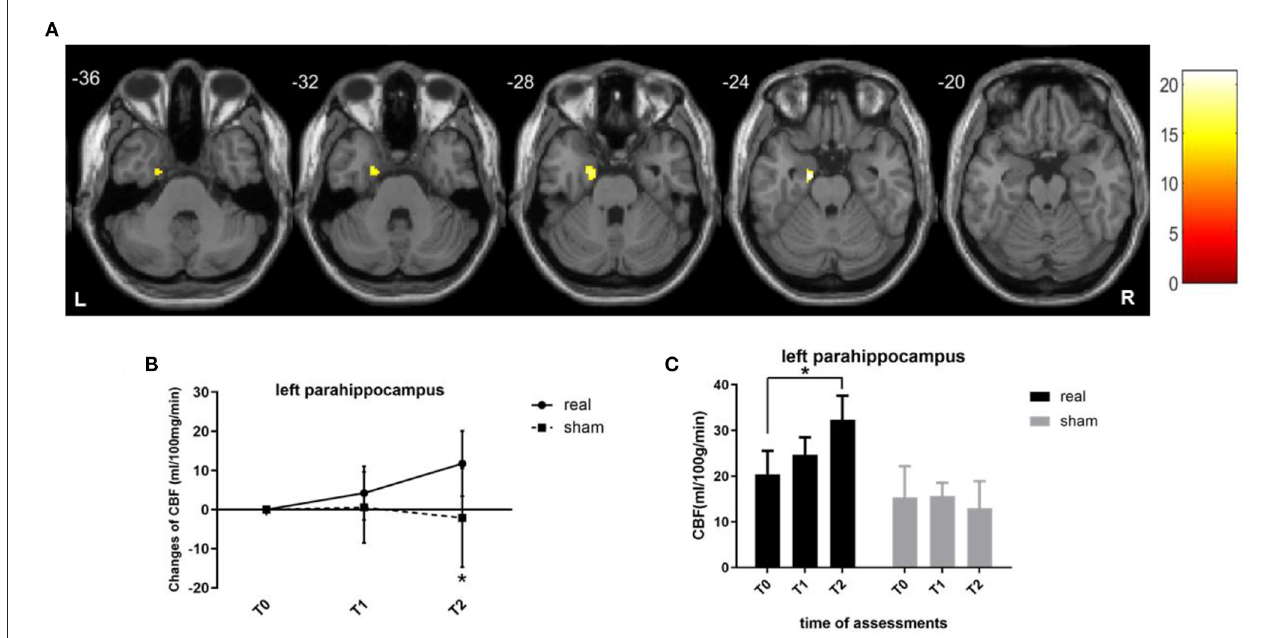
FIGURE3 CBF changes at the voxel level. (A) Brain regions where regional CBF demonstrated treatment main effect. Brain images shown at an uncorrected threshold of p < 0.001, and slice numbers are in the MNI space. (B) Line graphs showing the regional CBF changes in the cluster of left parahippocampus. (C) Bar graphs showing the mean CBF values in the cluster of the left parahippocampus for the real rTMS (in black) and sham (in gray) groups. CBF, cerebral blood flow; MNI, Montreal Neurologic Institute. * p < 0.05. Error bars indicate SD.